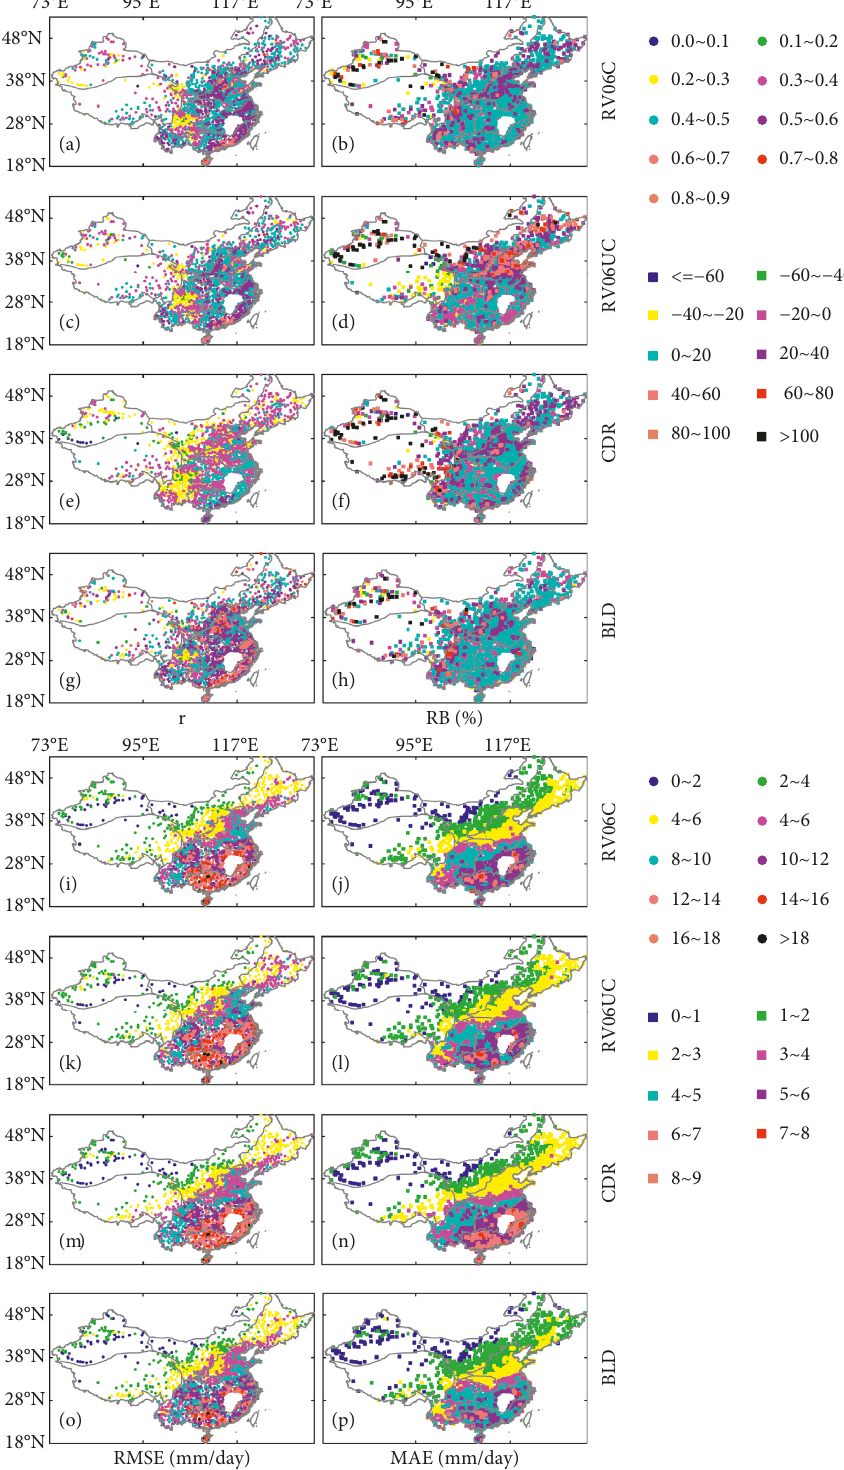
Figure 5: Spatial distributions of continuous statistical indices for the RV06C, RV06UC, CDR, and BLD product during the period from March 2014 to June 2018 over Mainland China. From left to right, the columns represent r RB (%), RMSE (mm/day), and MAE